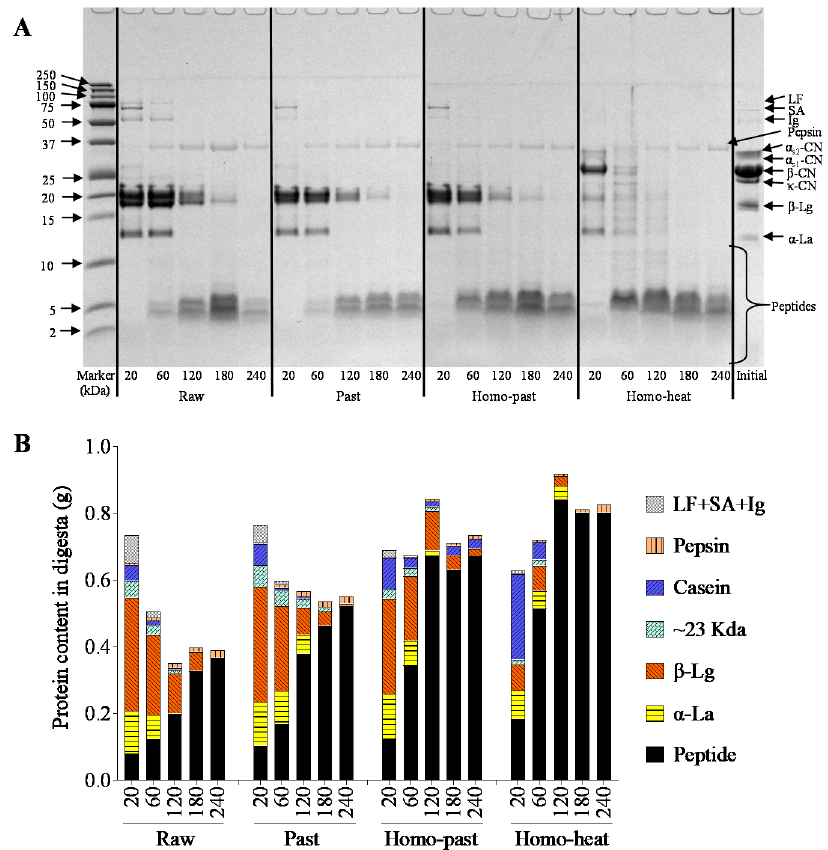
Figure 8. ( A ) Reducing tricine SDS-PAGE patterns and ( B ) protein contents of the digesta obtained from raw, pasteurized (Past), homogenized and pasteurized (Homo–past), and homogenized and heated (Homo–heat) sheep milks. The numbers (20, 60, 120, 180, 240) refer to different gastric emptying times (min). Initial refers to before digestion. The protein concentration in each sample for tricine SDS-PAGE was 1